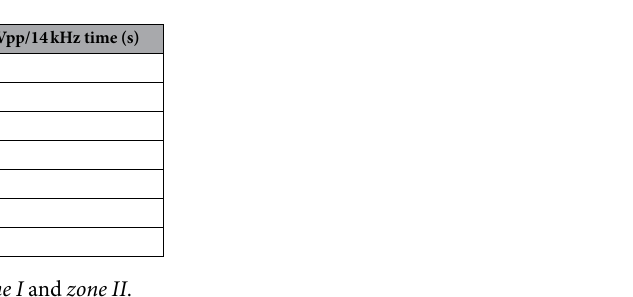
Table 2. Time boundary between zone I and zone II